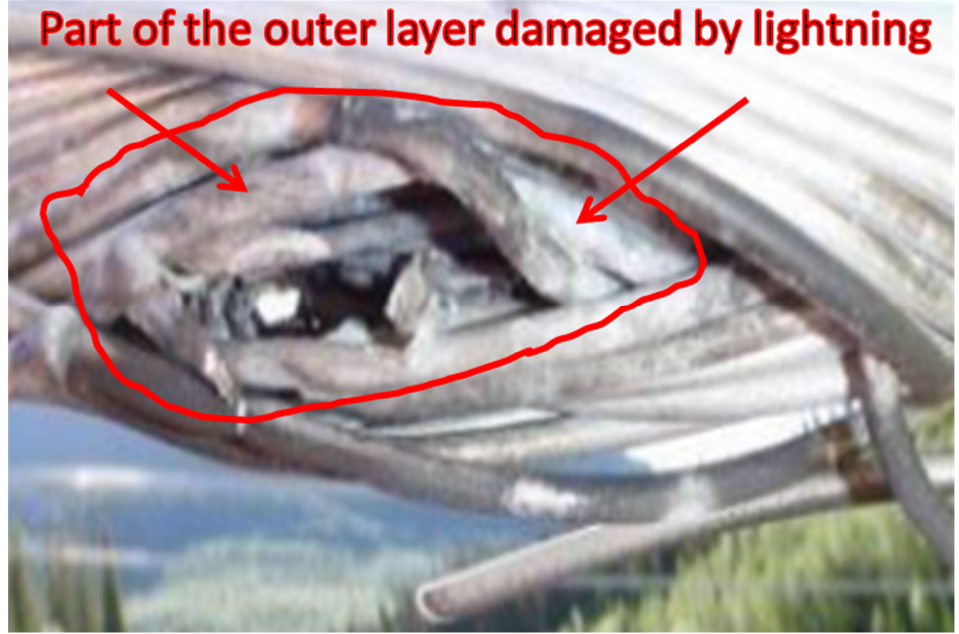
Figure 8. Image of conductor outer layer damaged by lightning [39].